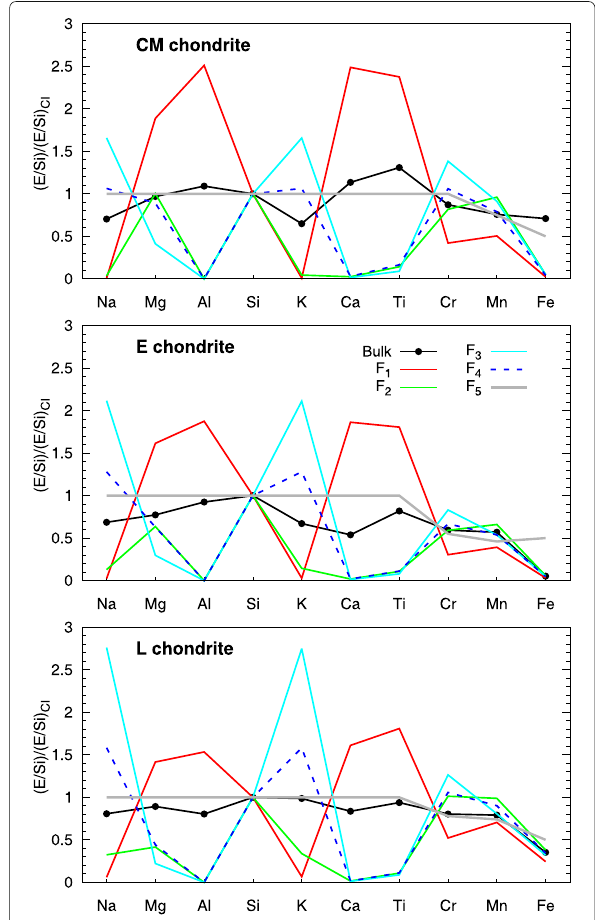
Fig. 7 Chemical compositions of the components, F n ’s determined by the calculation, shown for CM, E and L chondrites, normalized to CI and Si. Bulk: average composition of bulk chondrites (silicates) is shown for comparison